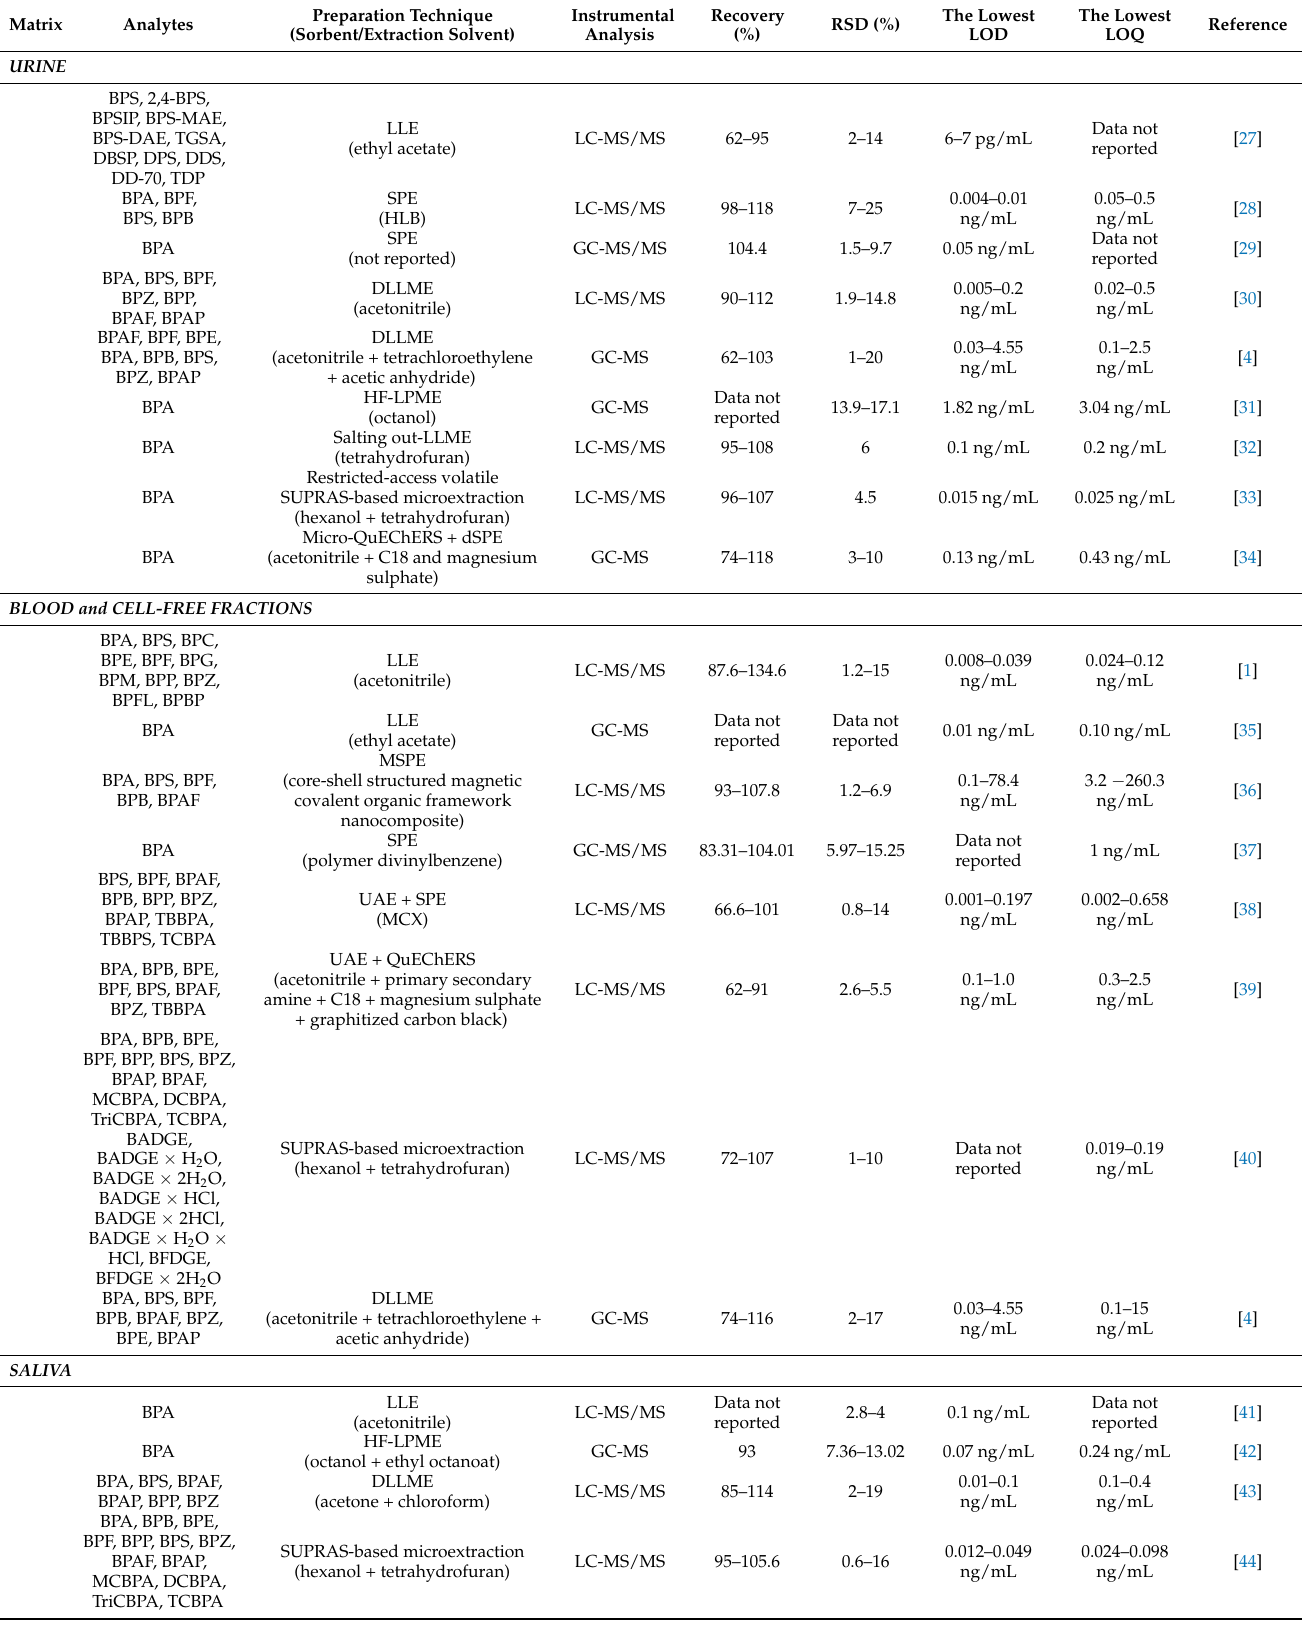
Table 1. The most sensitive methods for determining BPA and its analogues in each